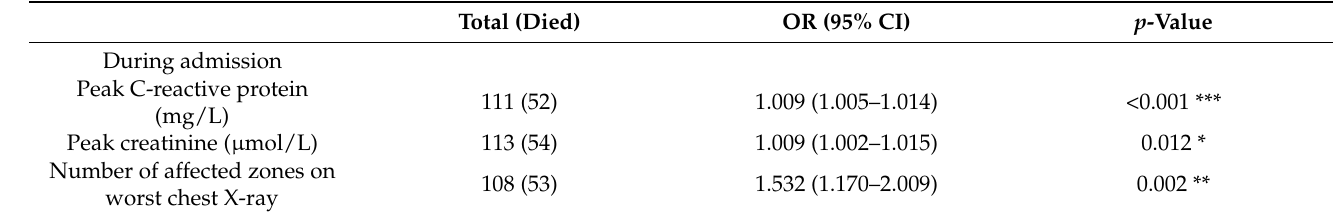
Table 1. Results of univariate logistical regression of categorical variables against inpatient death. OR, Odds ratio; CI, Confidence interval. Ɨ , As opposed to care home residence or supported living. *, p < 0.05; ***, p < 0.001.